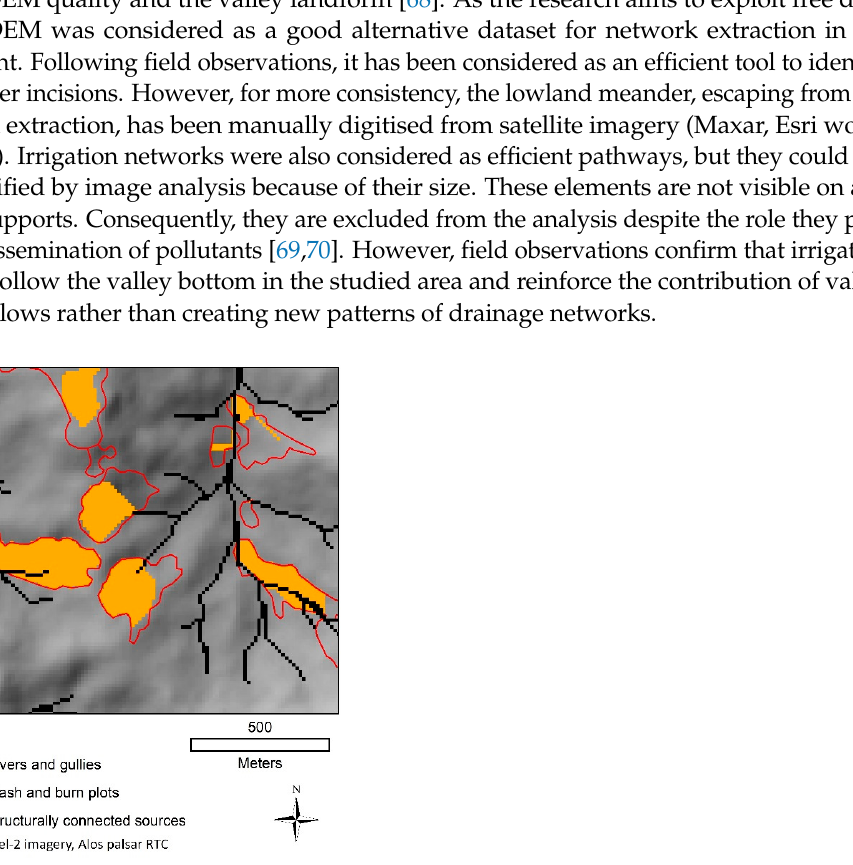
Figure 4. Flowchart to define the structural connectivity model.